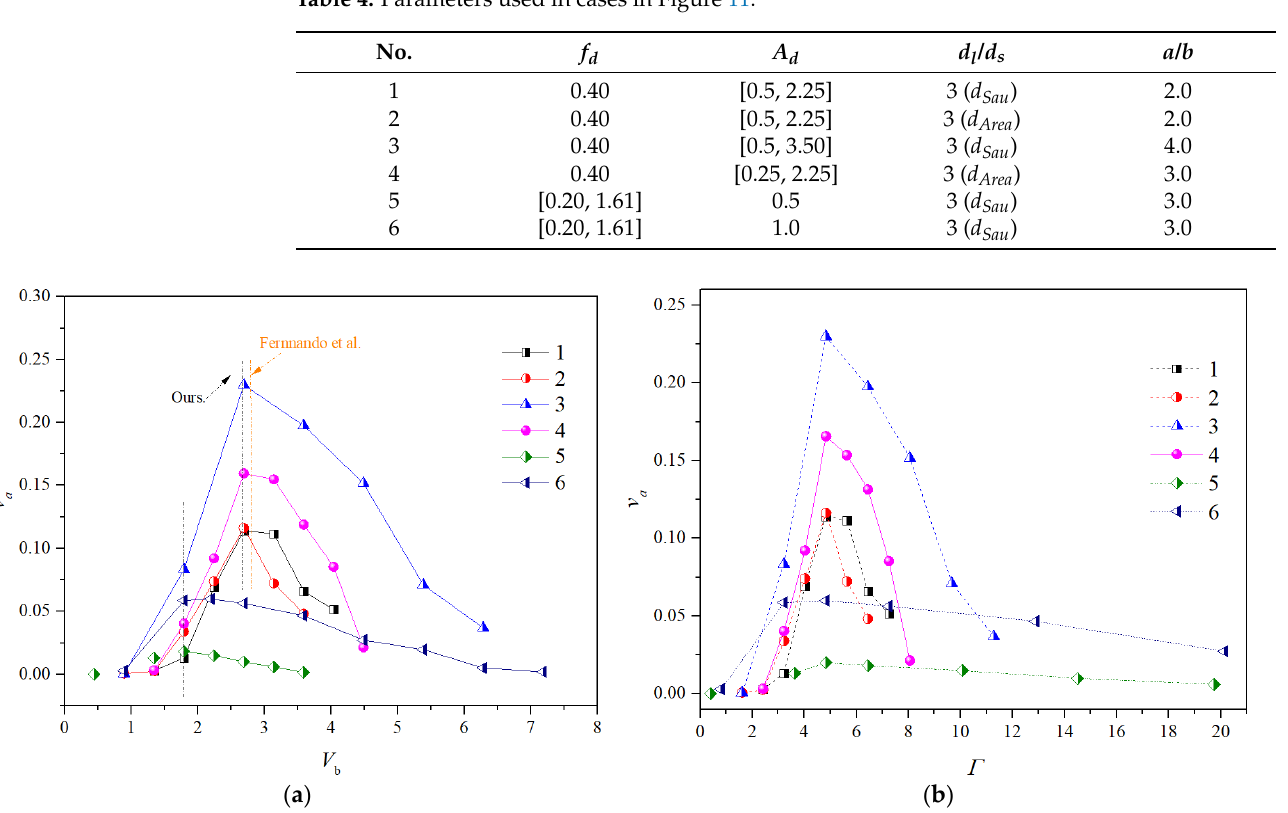
Figure 12. Response of v a to A d ⋅ f d 0.5 . In addition, Figure 13a shows that the shape of the intruder has a significant impact on its ascending. This seems to be different from the conclusion in [26] that the shape of